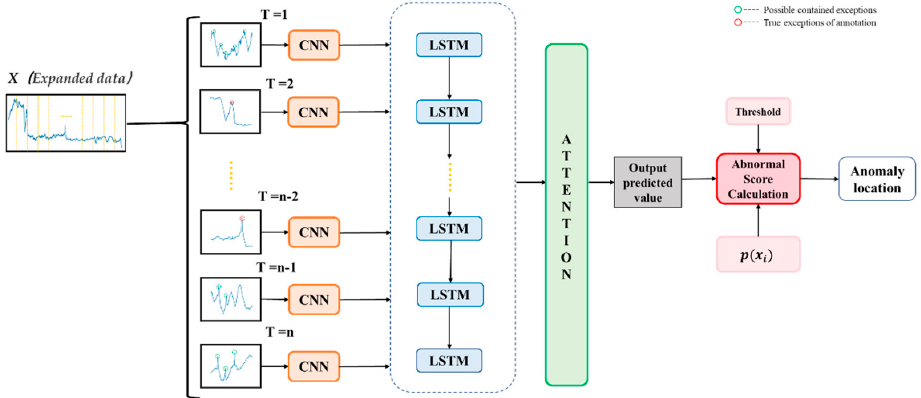
Figure 4. The simple flow chart of the proposed anomaly detection.